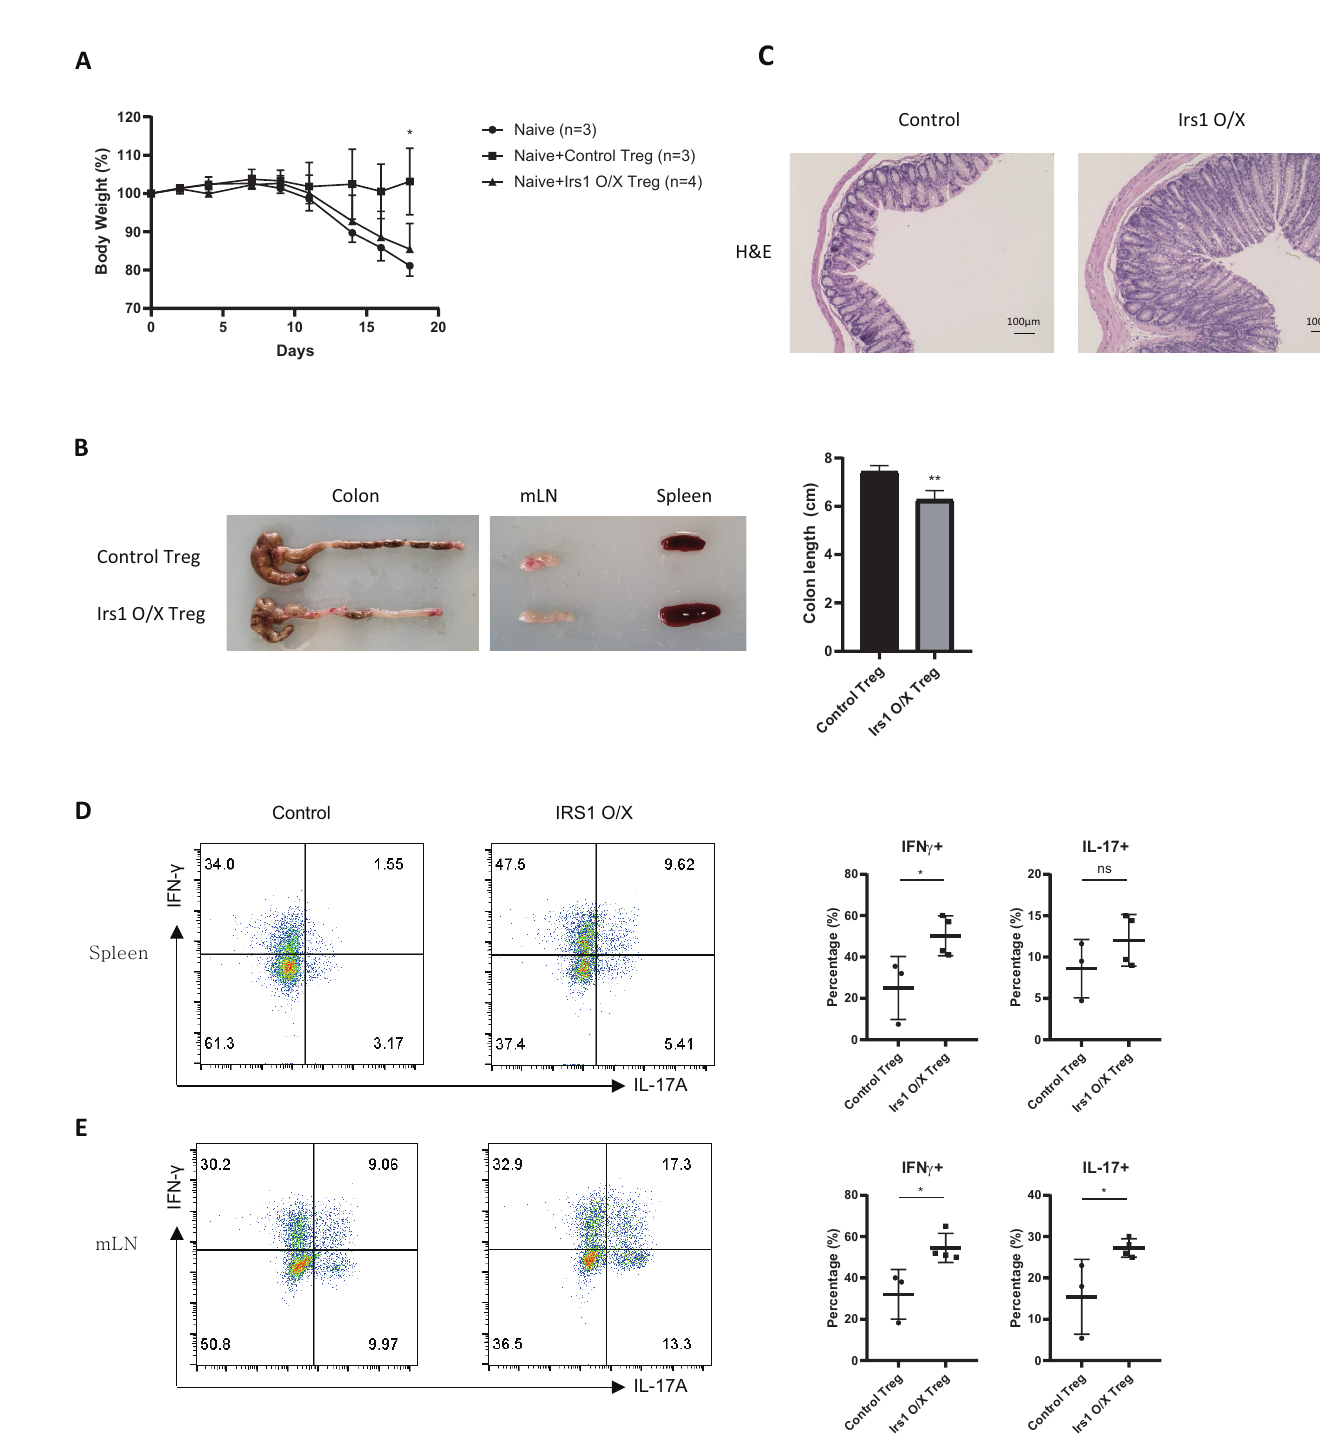
Figure 5. The suppressive function of IRS1-overexpressing Treg cells is impaired in vivo. ( A ) Body weight of Rag1 KO mice was measured after injection of naïve CD4 T cells (5 × 10 5 ), either alone or together with Treg cells (1 × 10 5 ) (n = 3 or 4 for each group). ( B ) Morphology of the colon, mLN, and spleen. ( C ) Histology of the clone stained using H & E. ( D , E ) IFN- γ + or IL-17 + cells (CD4 + gated population) in the spleen ( D ) or mesenteric lymph nodes ( E ) were measured via flow cytometry. The bar graph next to the flow cytometry plot shows data pooled from three independent experiments. The error bars represent SD, and p -values were analyzed via t -test. * p < 0.05, ** p < 0.01. ns: not